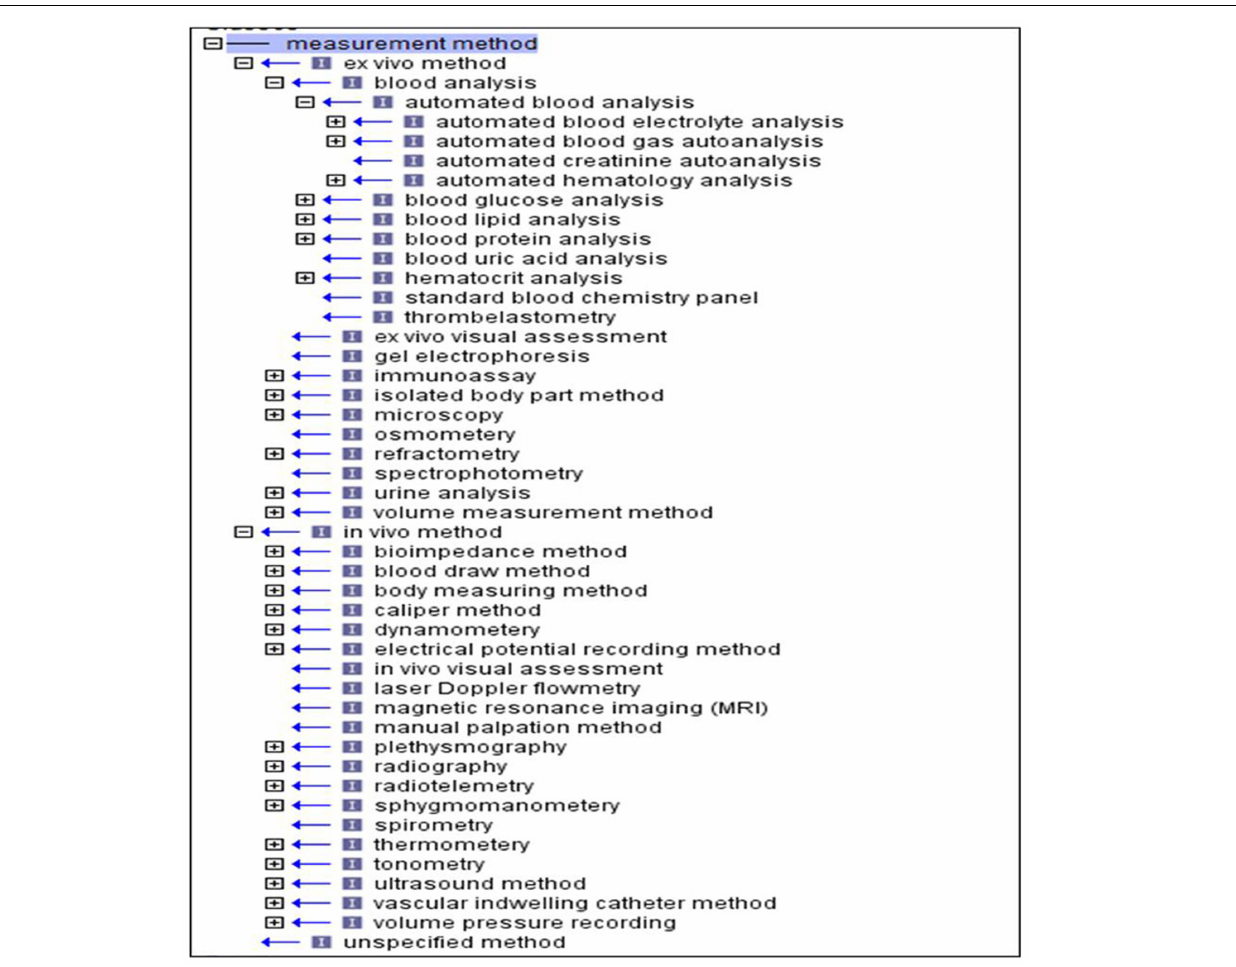
FIGURE 4 |The Measurement Method Ontology structure is based on two major branches, “ ex vivo ” and “ in vivo ” and the underlying mechanism or technique used in the